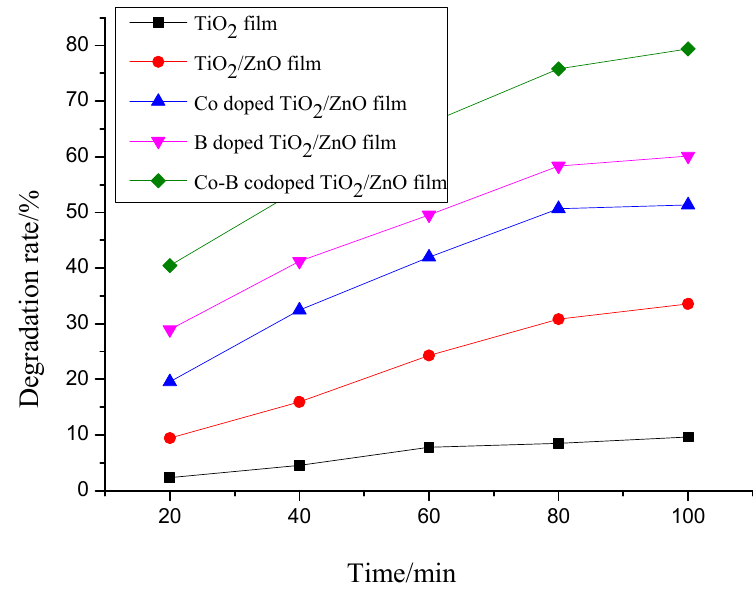
Figure 4. Decomposition kinetics of formaldehyde solutions using pure TiO 2 , composite TiO 2 /ZnO, Co doped TiO 2 /ZnO, B doped TiO 2 /ZnO, and Co-B codoped TiO 2 /ZnO films on glass substrates under visible light irradiation for 100 min.